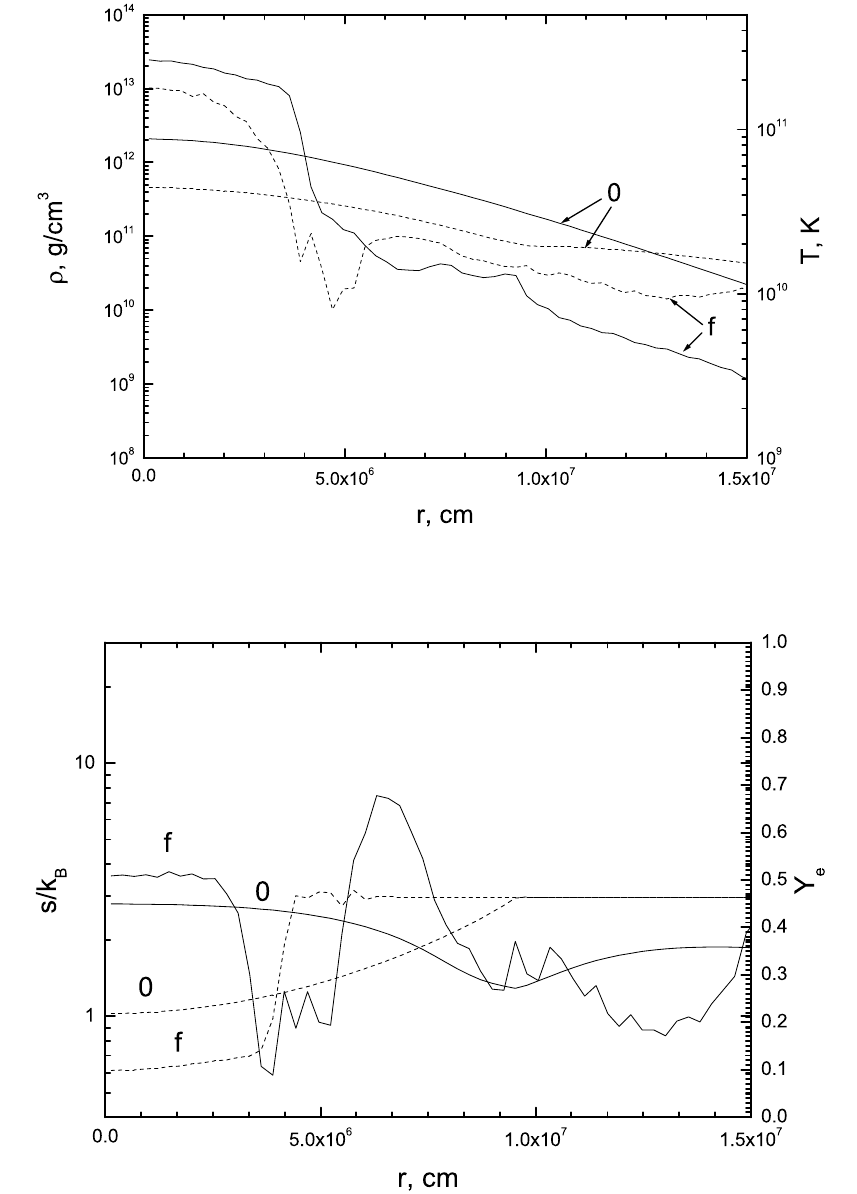
Figure 2. Initial model ( t ≈ 0) and the end of calculations ( t f = 12 ms) in the equatorial plane. ( Top ): profiles of density ρ (solid lines) and temperature T (dashed lines) as functions of cylindrical radius. ( Bottom ): profiles of entropy per nucleon s / k B (solid lines), the number of electrons Y e (dashed lines) as functions of cylindrical